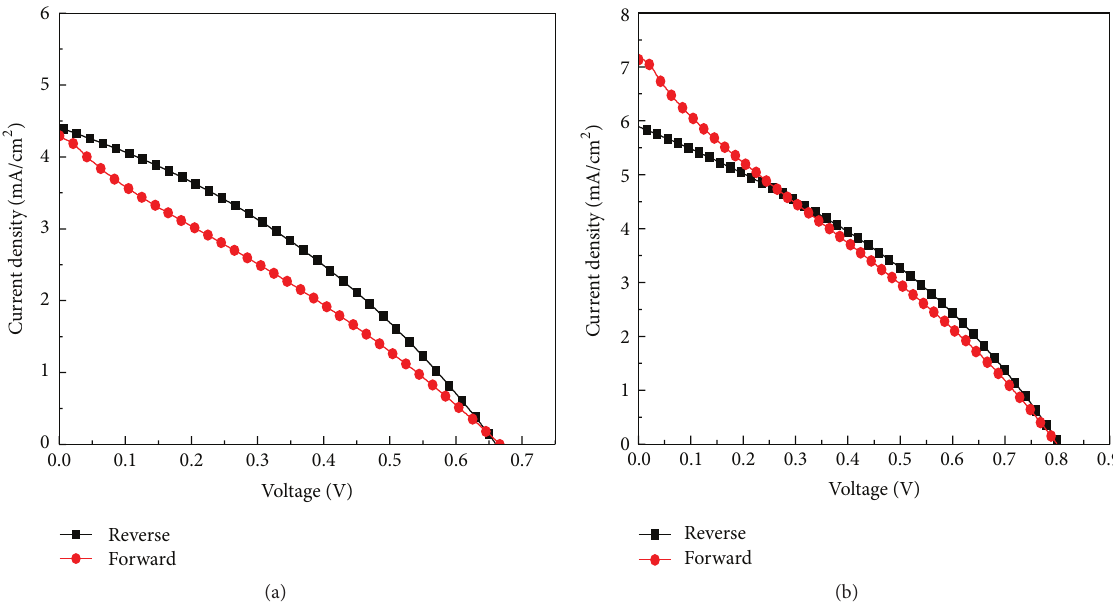
Figure 13: Hysteresis behavior of perovskite solar cells. The typical J - V characteristics of (5-AVA ) 𝑥 ( MA ) (1−𝑥) PbI (3−𝑦) Cl 𝑦 -based PSCs with (a) single- and (b) double-mesoporous layer at different scanning directions: from short circuit to forward bias (black) and from forward bias to short circuit